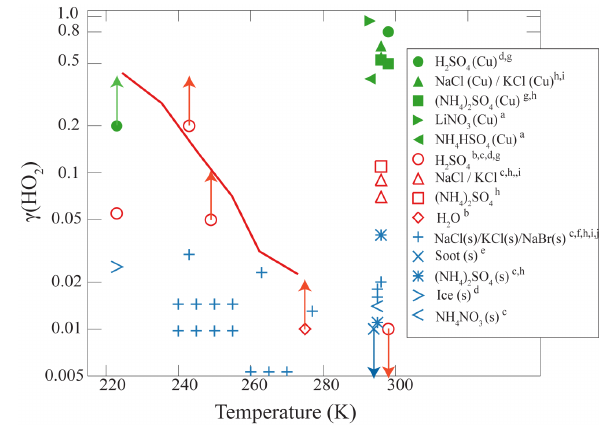
Fig. 2. Laboratory data reported in the literature for the reactive uptake coefficient γ (HO 2 ) by different surfaces as a function of temperature. Vertical arrows indicate “greater than” or “less than”. Open symbols indicate aqueous surfaces, closed symbols indicate copper-doped aqueous surfaces, and other symbols indicate solid surfaces (noted as (s) in the legend). The solid red line is the median value of γ (HO 2 ) computed in GEOS-Chem along the ARCTAS flight tracks using the Thornton et al. [2008] parameterization. Literature references are given by footnotes in legend: (a) Mozurkewich et al. [1987]; (b) Hanson et al. [1992]; (c) Gershenzon et al. [1995]; (d) Cooper and Abbatt [1996]; (e) Saathoff et al. [2001]; (f) Remorov et al. [2002]; (g) Thornton and Abbatt [2005]; (h) Taketani et al. [2008]; (i) Taketani et al. [2009], (j)Loukhovitskaya et al. [2009].